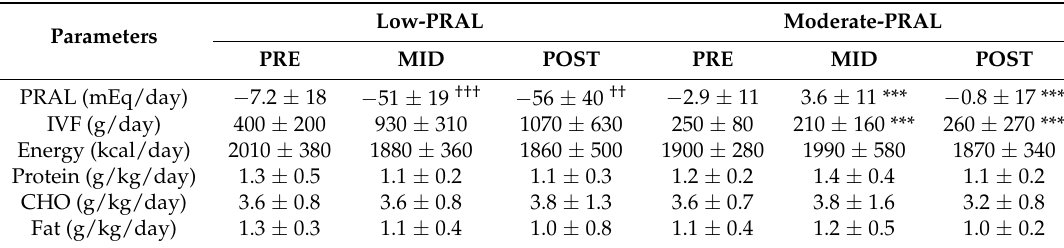
Table 3. Dietary intake data in women before (PRE), in the middle (MID) and after (POST) the 12-week diet period.